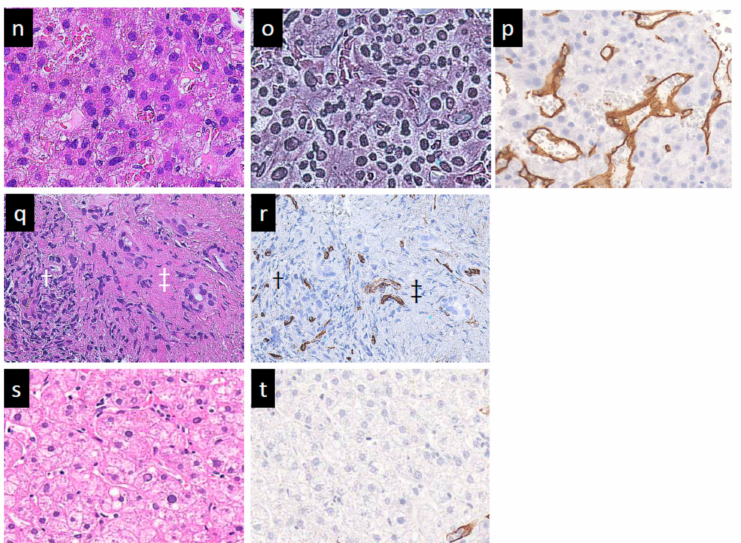
Figure 3. Grayscale ultrasound (US) and contrast-enhanced US with Sonazoid (SCEUS) images before and after radiotherapy (RT) for an HCC lesion (maximum diameter: 34 mm) in segment III/IV, evaluated as residue after RT. RT was selected as treatment because the lesion was located adjacent to the left portal vein and the tumor size was more than 3 cm (as the maximum diameter). Hypofractionated radiotherapy was performed as the bowel organ was adjacent to the lesion. Before RT ( a – c ): A hyperechoic lesion was observed using grayscale US ( a ). This lesion showed hypervascularity during arterial phase (AP) SCEUS ( b ) and hypoechoic (perfusion defect) during the post-vascular phase (PVP) ( c ). One month after RT ( d – f ): The tumor size did not change on grayscale US ( d ). Using SCEUS, the HCC lesion showed hypervascularity with a partially hypovascular area (curved arrow) during the AP ( e ) and was hypoechoic during the PVP ( f ). The surrounding liver parenchyma showed slight hypervascularity during the AP ( e ) and was hypoechoic during the PVP ( f ). Four months after RT ( g – i ): The tumor size did not change on grayscale US ( g ). Using SCEUS, the HCC lesion showed hypervascularity with a partially hypovascular area (curved arrow) during the AP ( h ). The surrounding liver parenchyma showed apparent hypervascularity during the AP ( h ). Both the HCC lesion and the surrounding liver parenchyma appeared as a perfusion defect during the PVP ( i ). Thirteen months after RT ( j – m ): The tumor size did not change on grayscale US ( j ). Using SCEUS, compared with 4 months after RT, the HCC lesion showed hypervascularity during the AP ( k ). AP SCEUS showed slight hypervascularity of the surrounding liver parenchyma ( k ). Both the HCC lesion and the surrounding liver parenchyma appeared as a perfusion defect during the PVP ( l ). The boundary between the HCC and the surrounding liver parenchyma was unclear ( l ). After re-injection of Sonazoid during the PVP, both the HCC and the surrounding liver parenchyma showed hypervascularity ( m ). In this case, tumor size reduction and the disappearance of tumor vascularity were not observed during 13 months follow-up. Arrowheads indicate the margins of the HCC lesion. Arrows show the margins of the irradiated surrounding liver parenchyma. Pathological findings obtained from irradiated HCC area ( n – p ), irradiated surrounding non-tumor area ( q , r ), and non-irradiated non-tumor area ( s , t ) at 13 months after RT. For the irradiated HCC area, hematoxylin and eosin (HE) staining showed obvious cell atypia. Specifically, hypercellularity and larger, irregularly shaped nuclei can be seen. The nuclear cytoplasmic ratio is significantly higher. A few multinucleated giant cancer cells can be seen ( n ). Silver staining showed that reticular fibers have totally disappeared, resulting in poorly differentiated HCC ( o ). CD34 staining showed strong diffuse expression of CD34, suggesting increased neovascularization resulting from sinusoidal capillarization and the formation of sinusoid vascular endothelium in HCC ( p ). Irradiated surrounding non-tumor area showing hypervascularity during arterial phase SCEUS (* mark seen in ( k )): HE staining showed neither cancer cells nor hepatocytes. Infiltration of inflammation cells (†) and severe fibrosis (‡) are noted ( q ). CD34 staining showed diffuse expression of CD34 in infiltration of inflammation cells (†) and severe fibrosis regions (‡) ( r ). Non-irradiated non-tumor area: HE staining showed normal hepatocytes with the normal nucleus shape and the nuclear cytoplasmic ratio. Thin trabeculae are clearly visualized ( s ). The negative expression of CD34 is seen ( t